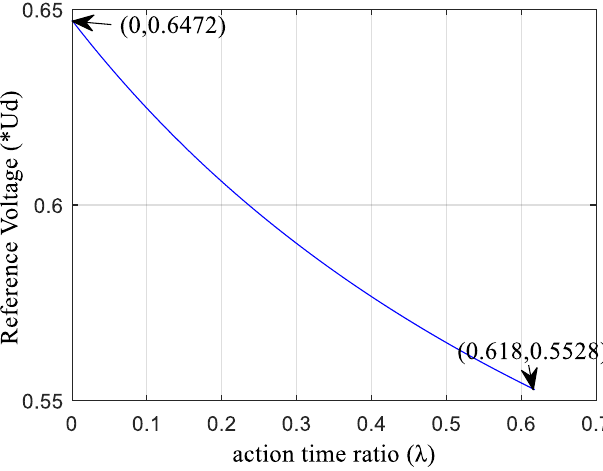
Figure 6. The relationship between the reference voltage and λ.